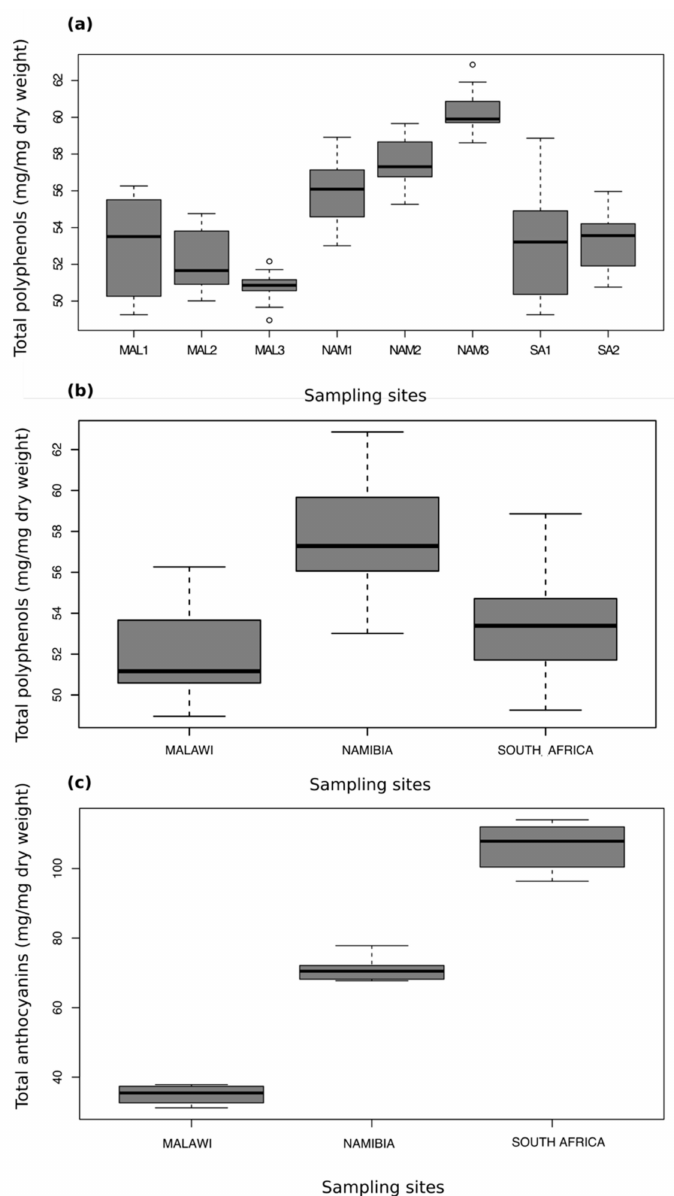
Figure 2. ( a ) Box plot showing the results of the total polyphenolics assay between samples collected from all sampling sites. Analysis of variance (ANOVA) followed by Tukey’s post-hoc tests were used to assess significant interactions at p < 0.05. No significant differences in polyphenols were detected between samples within the same country (Malawi, South Africa, and Namibia). The Namibian samples possessed significantly higher polyphenolics than all the Malawian samples and all of the South African samples, with the exception of the interaction between NAM1 (“Etusis”) and SA2 (“Waterberg”). ( b ) Box plot showing the results of the total polyphenolics assay with the samples grouped by country. The Namibian samples possessed significantly higher phenolics than both South Africa and Malawi, whereas South Africa and Malawi did not differ significantly from one another. ( c ) Box plot showing the results of the total anthocyanins assay between samples pooled by major area (country). All interactions were determined to be significant at p <